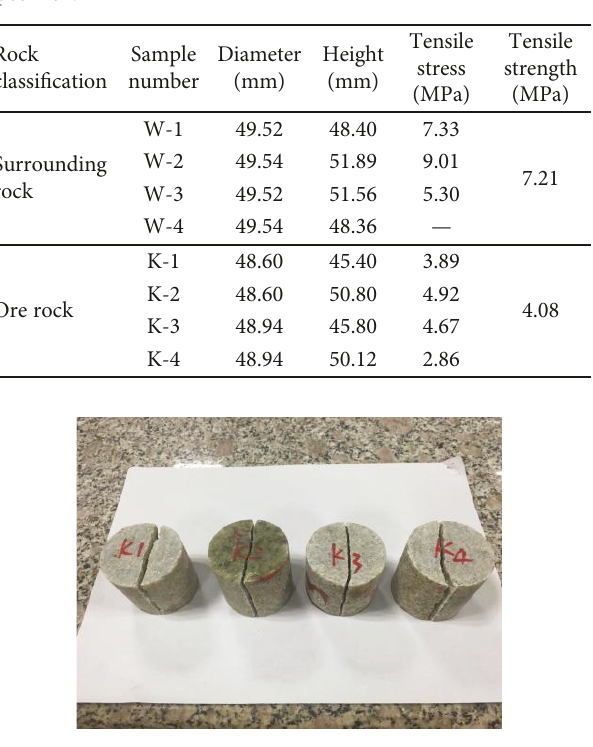
Figure 6: Failure mode of some ore rock tensile specimens.